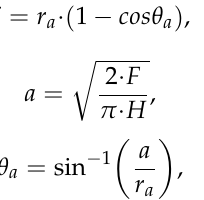
Figure 2. SEM images of the polycrystalline diamond abrasive.